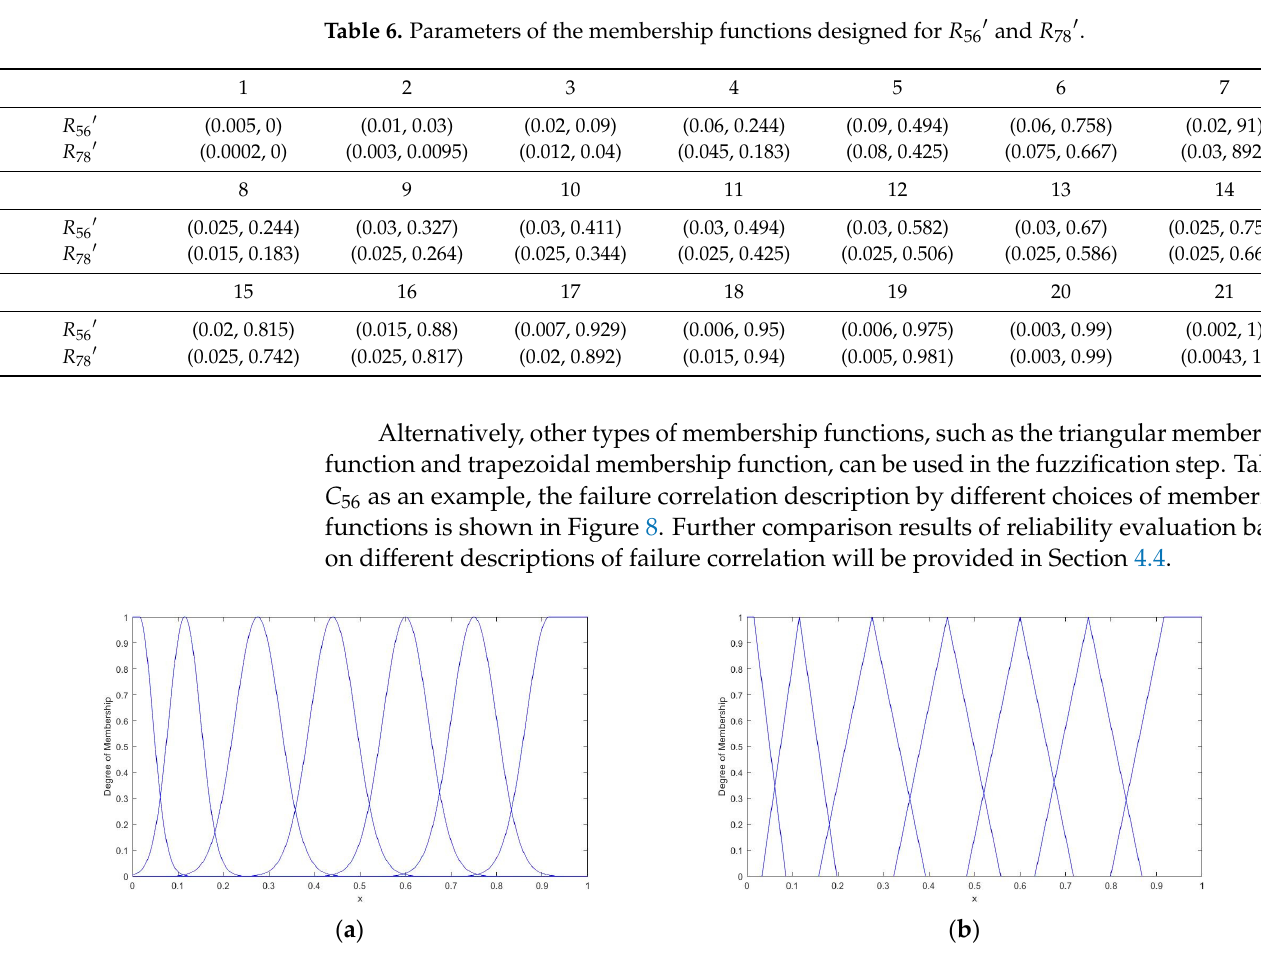
Figure 8. Description of C 56 by different types of membership functions: ( a ) Gaussian member- ship function and double Gaussian membership function; ( b ) triangular membership function and trapezoid membership function.